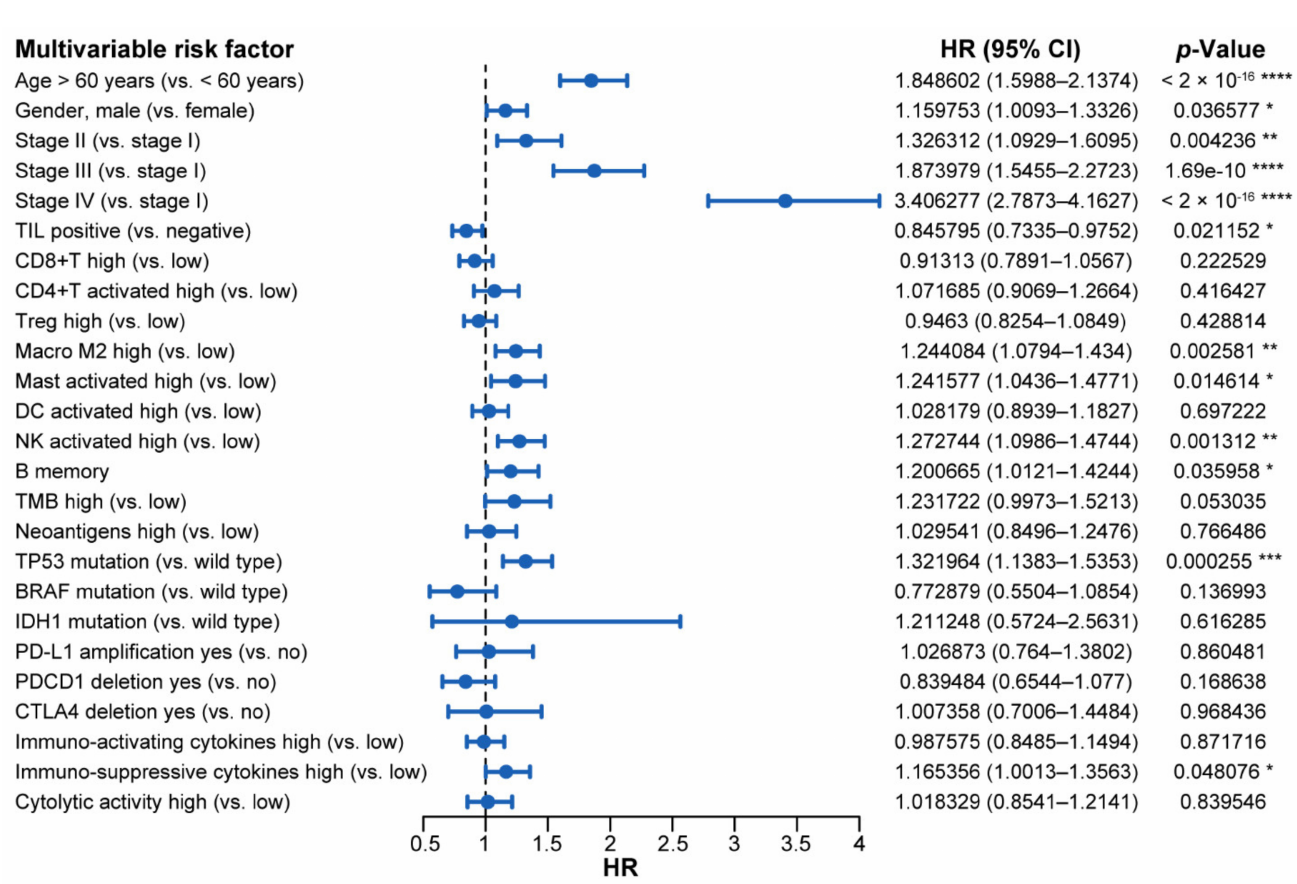
Figure 5. The forest plot of prognostic values for multivariable cox proportional hazard regression models. Abbreviations: HR: hazard ratio; CI: confidence interval; TIL: tumor infiltrating lymphocyte; TMB: tumor mutation burden. ****, p < 0.0001; ***, p < 0.001; **, p < 0.01; *, p <